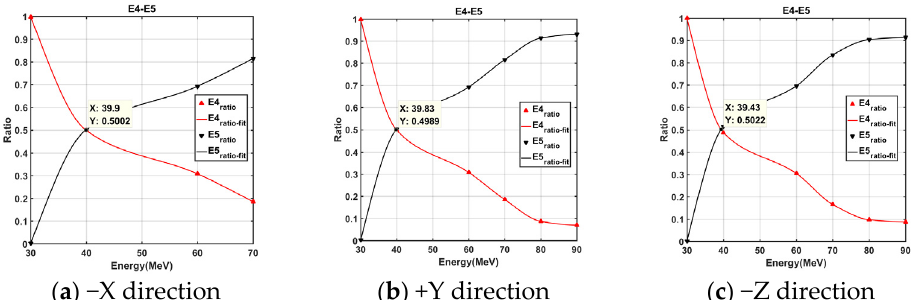
Figure 15. Calibration results of proton energy channel in three directions (40 MeV).